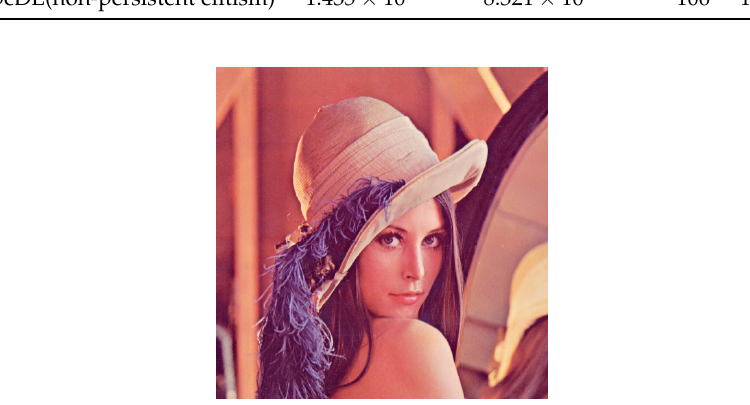
Figure 7. Lena image.